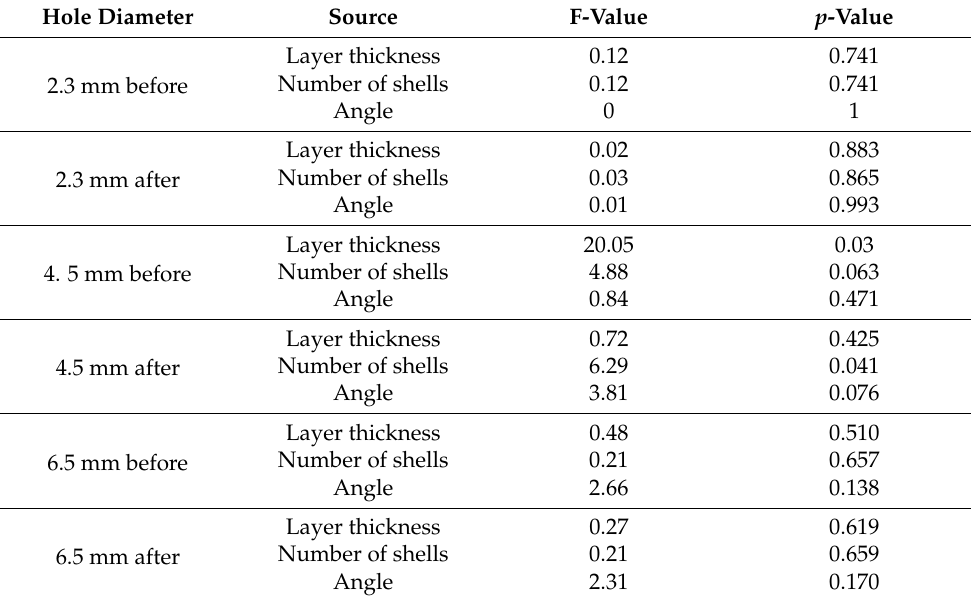
Table 8. ANOVA results on parameters effects on holes diameter in test part 2. Hole